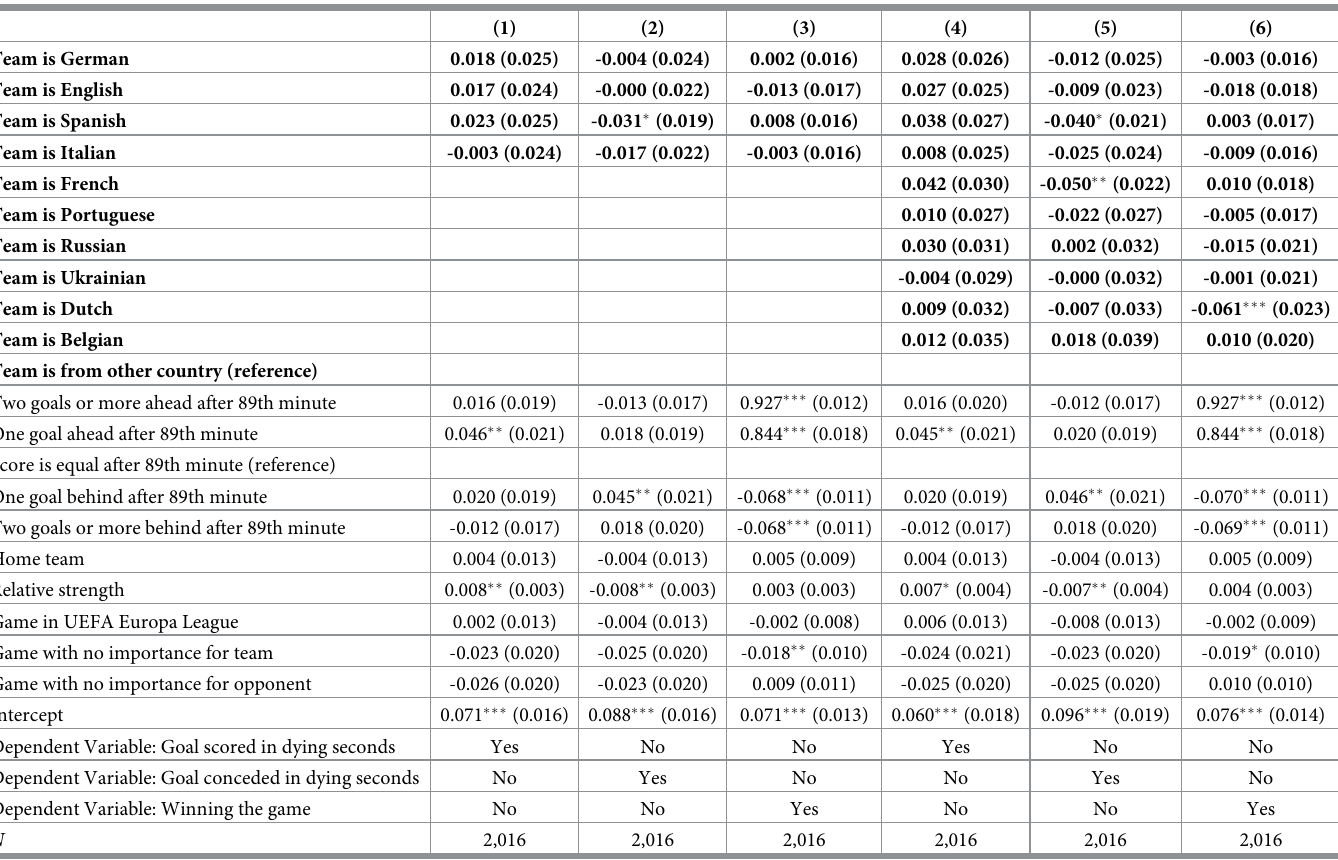
Table 3. Results: Multiple team nationality indicators as main explanatory